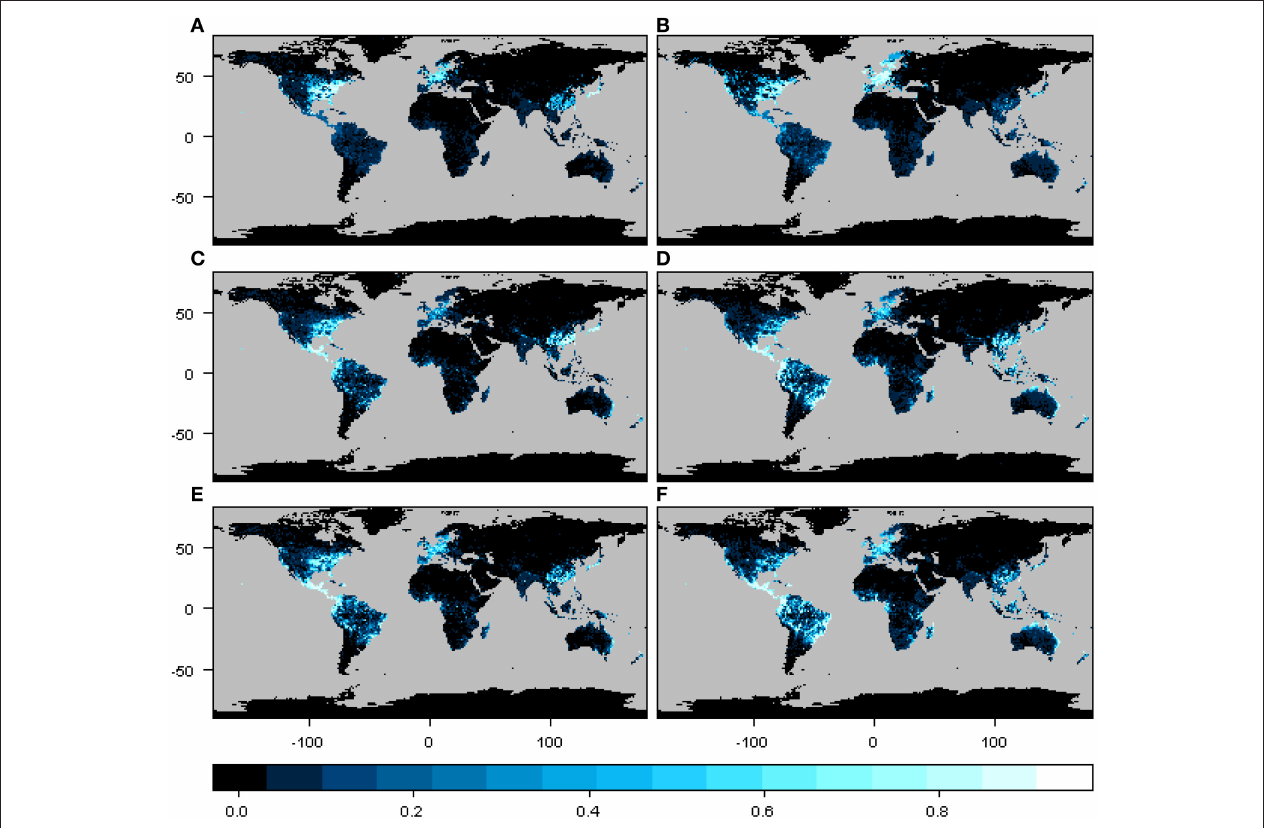
FIGURE 3 | Spatial interaction or infection index for three cases of host range size and different levels of phylogenetic constraint. Maps in (A,C,E) correspond to the interaction or infection index for host plant genera from the original host-beetle database (M 1 ), and maps in (B,D,F) correspond to the interaction or infection index for host plant genera from the phylogenetic tree (M 2 ). The three cases correspond to a narrow host range and phylogenetically constrained species ( Xyleborus xylographus ), a wide host range vector and phylogenetically constrained species ( Xyleborus glabratus ) and a wide host range and phylogenetically dispersed species ( Xylosandrus crassiusculus ). Maps summarize information at 1-degree spatial